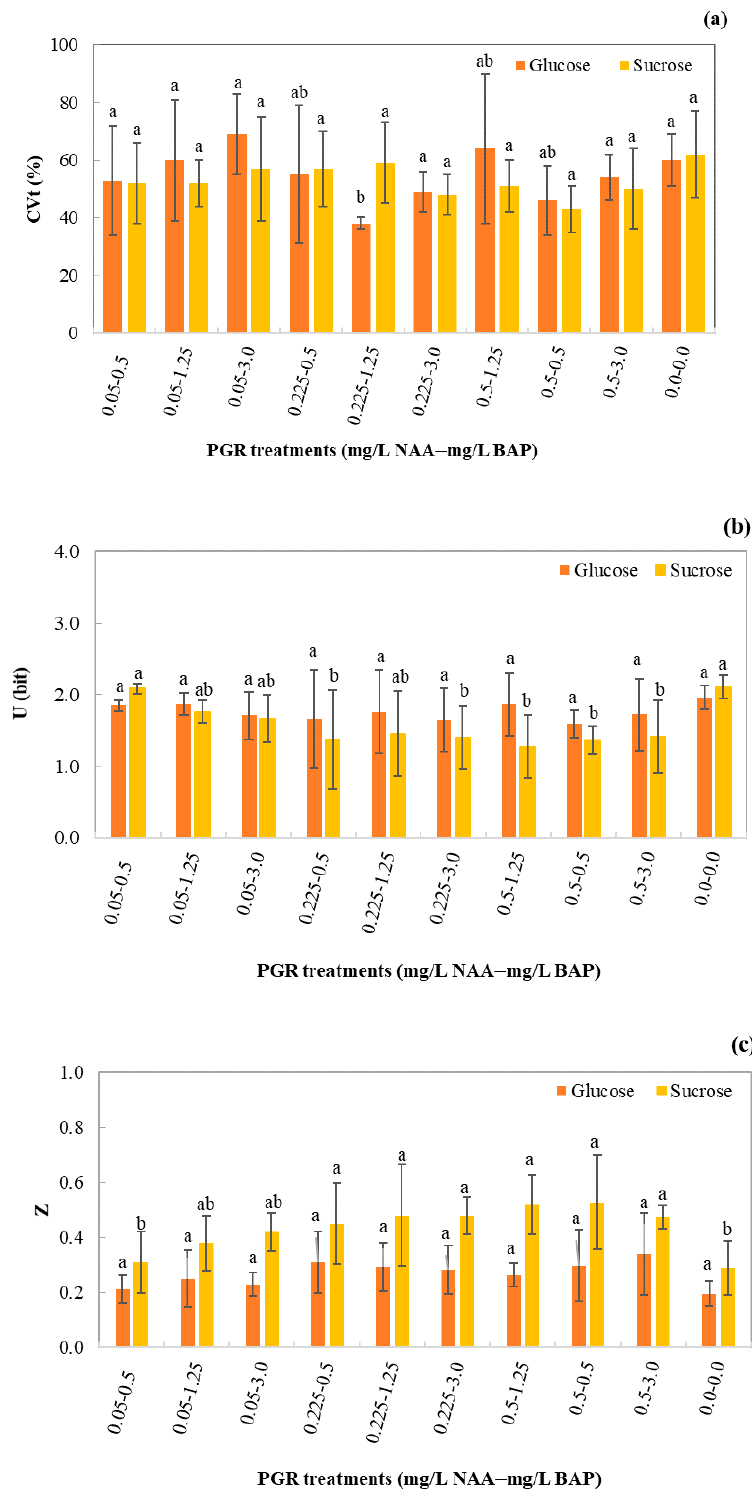
Figure 1. Germination uniformity and synchrony indexes: ( a ) Coefficient of variation of the germination (CVt) values; ( b ) Uncertainty (U) values; ( c ) Synchrony (Z) values of Taraxacum officinale seeds at different carbon sources at 2.3% and PGR treatments. Medium supplemented with NAA and BAP (in combination) at 18 °C and photoperiod 18/6 h light. Glucose (GLU); Sucrose (SUC); Plant growth regulators (PGR). Values are means ± SE of 4 replicates, containing 20 seeds each. Letters indicate significant differences from control at p ≤ 0.05.